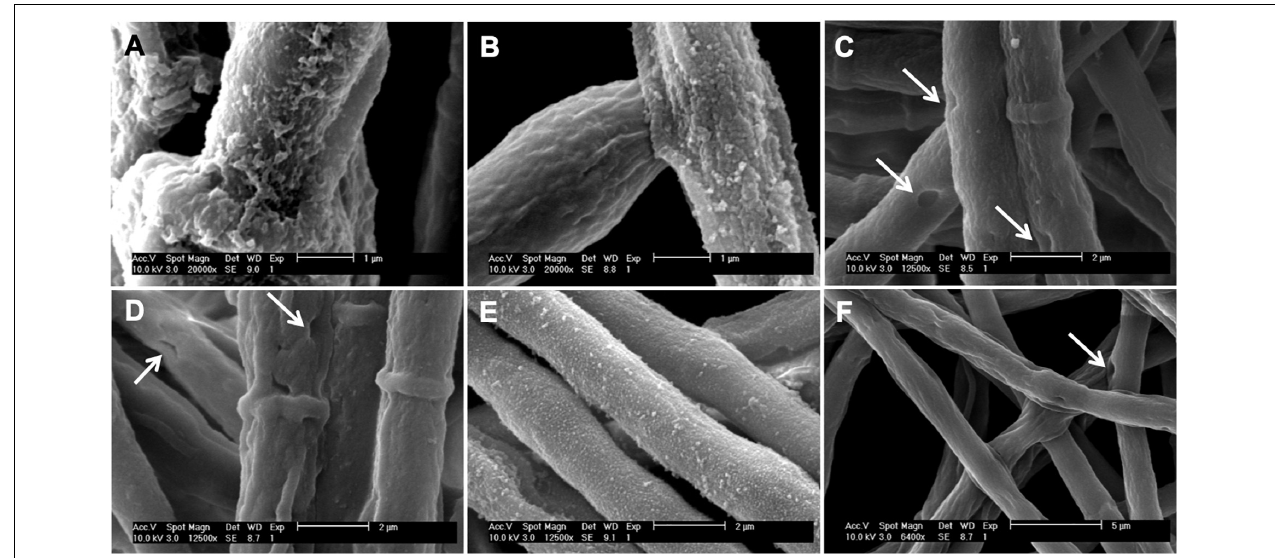
FIGURE 6 | Scanning electron micrographs of the A. alternata hyphae grown in (A) MM, (B) MMT, (C) MMP, (D) MM + pyroquilon, (E) MMT + pyroquilon and (F) MMP + pyroquilon. Arrows indicate holes in the cell wall when the fungus is grown in MM + pyroquilon, MMP and MMP +